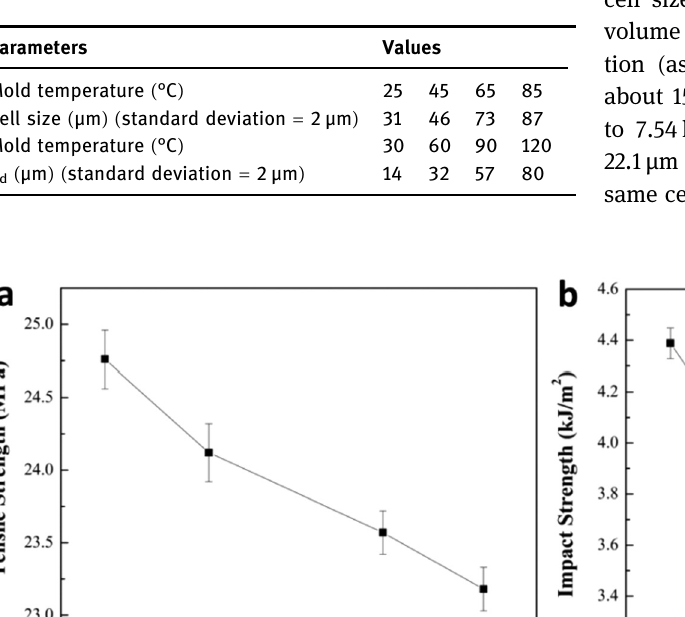
Table 2: Cell structural parameters of the PP foams obtained at di ff erent mold temperatures